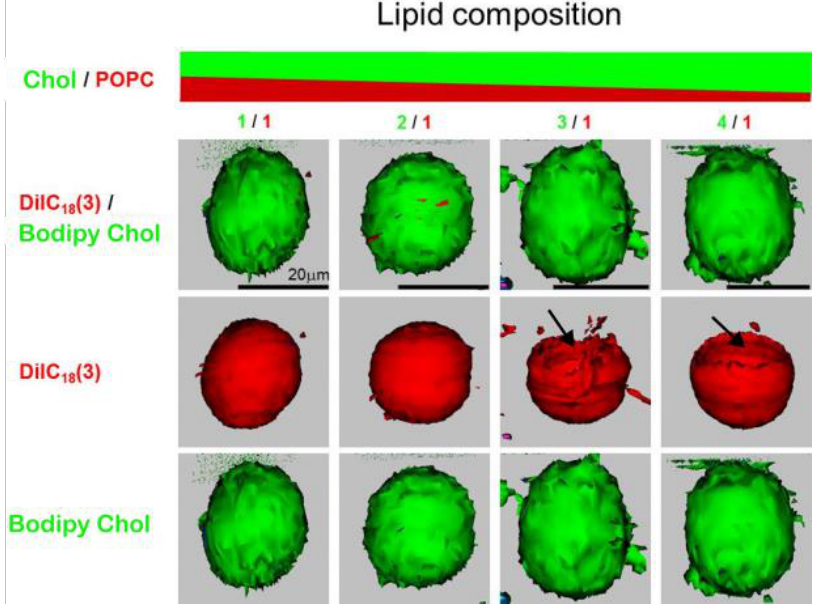
Figure 6. Confocal fluorescence images of GUVs made of Chol/POPC mixtures, with mixing ratios from 1 to 4 and recorded at 22 °C. Each vesicle contains PL and Chol analog probes, DiIC 18 (3) (red) and Bodipy Chol (green), respectively. In the upper row, each image is an overlay of two simultaneously acquired fluorescence signals from DiIC 18 (3) and Bodipy Chol. These same data are presented in the middle and bottom rows, but fluorescence signals originate from DiIC 18 (3) in the middle row and Bodipy Chol in the bottom row, respectively. We collected green and red signals in an independent mode. Each fluorophore was excited by its own individual excitation wavelength, and the resultant emission was collected, first for Bodipy Chol (green) and then for DiIC 18 (3) (red) data. This sequence was repeated over different Z-levels. This enables each fluorophore to be captured independently and in microseconds apart from each other. To gain a three-dimensional distribution of DiIC 18 (3) and Bodipy Chol in the GUV, Z-scan images were converted into surface-rendered images. Three-dimensional renderings of the Z-stack images were performed under the same settings, including threshold (lower limit set at 0.05 for both green and red) orientation, projected image brightness, etc. Arrows show the lack of fluorophore in certain parts of the vesicles. Data for Figure 6 are reproduced with permission from [20]. Copyright 2023, Springer nature BV.